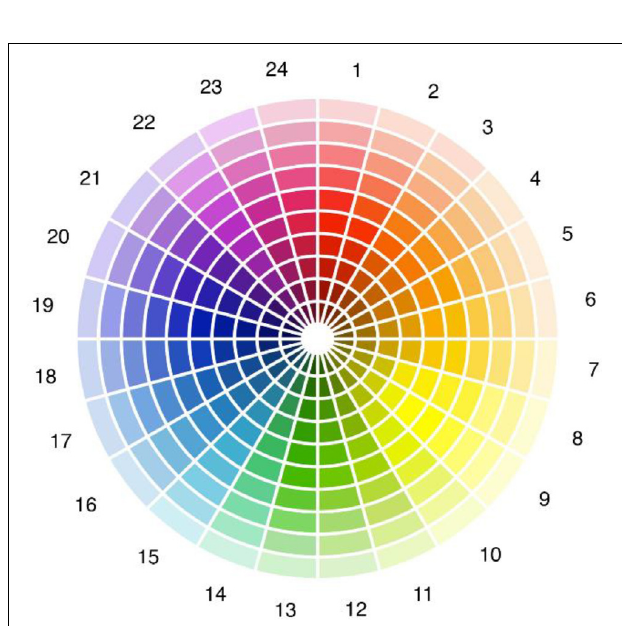
FIGURE 3 | Example of a green and orange student’s room at the university residence hall.